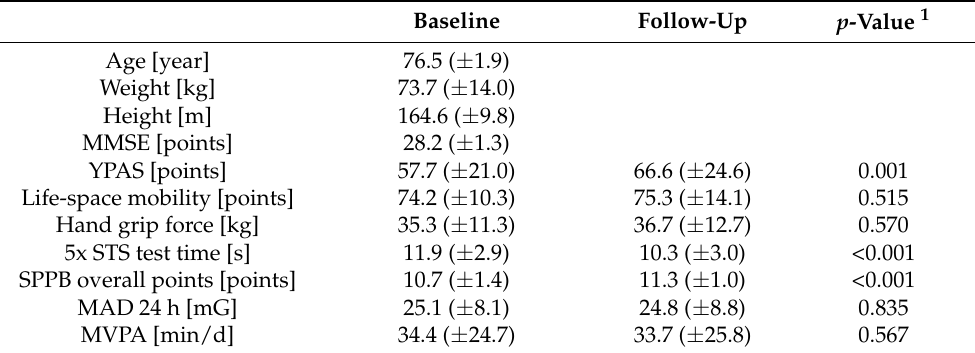
Table 1. Descriptive statistics of the study ( n = 86, female 64%) (mean (SD)). Baseline Follow-Up p -Value